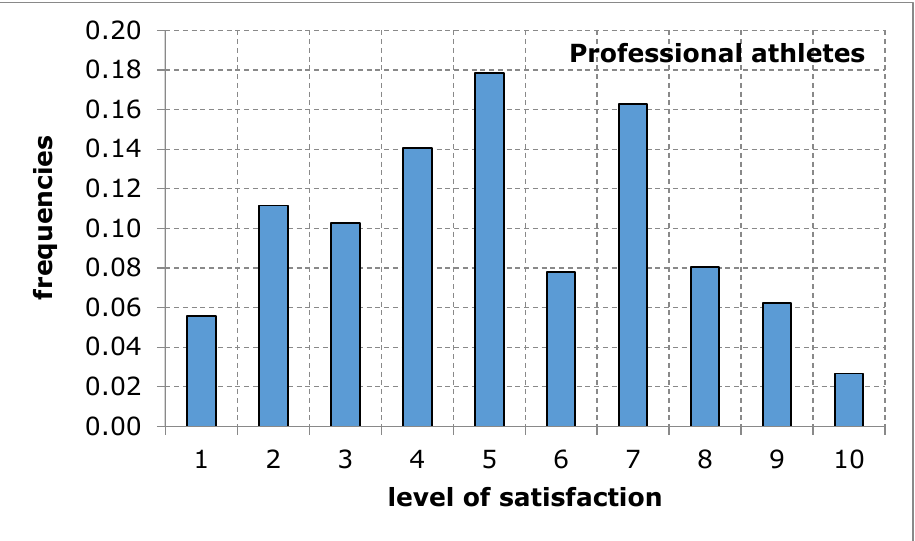
Figure 4. A sports and recreation facility is too far away, in the opinion of service recipients (professional athletes). Source: own work. Table 6. Statistical characteristics of the availability of sports and recreation facilities for the residents of the city of Poznan, in terms of place of residence.